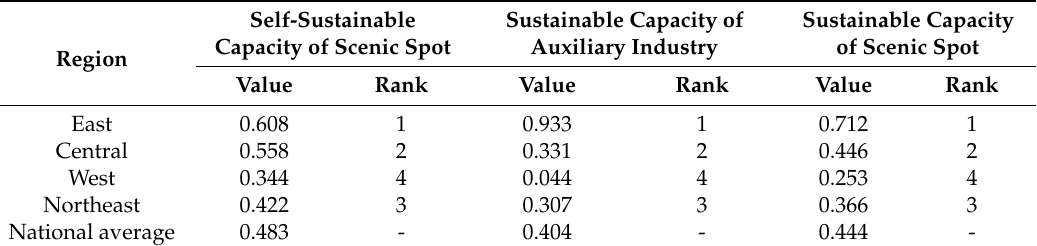
National average